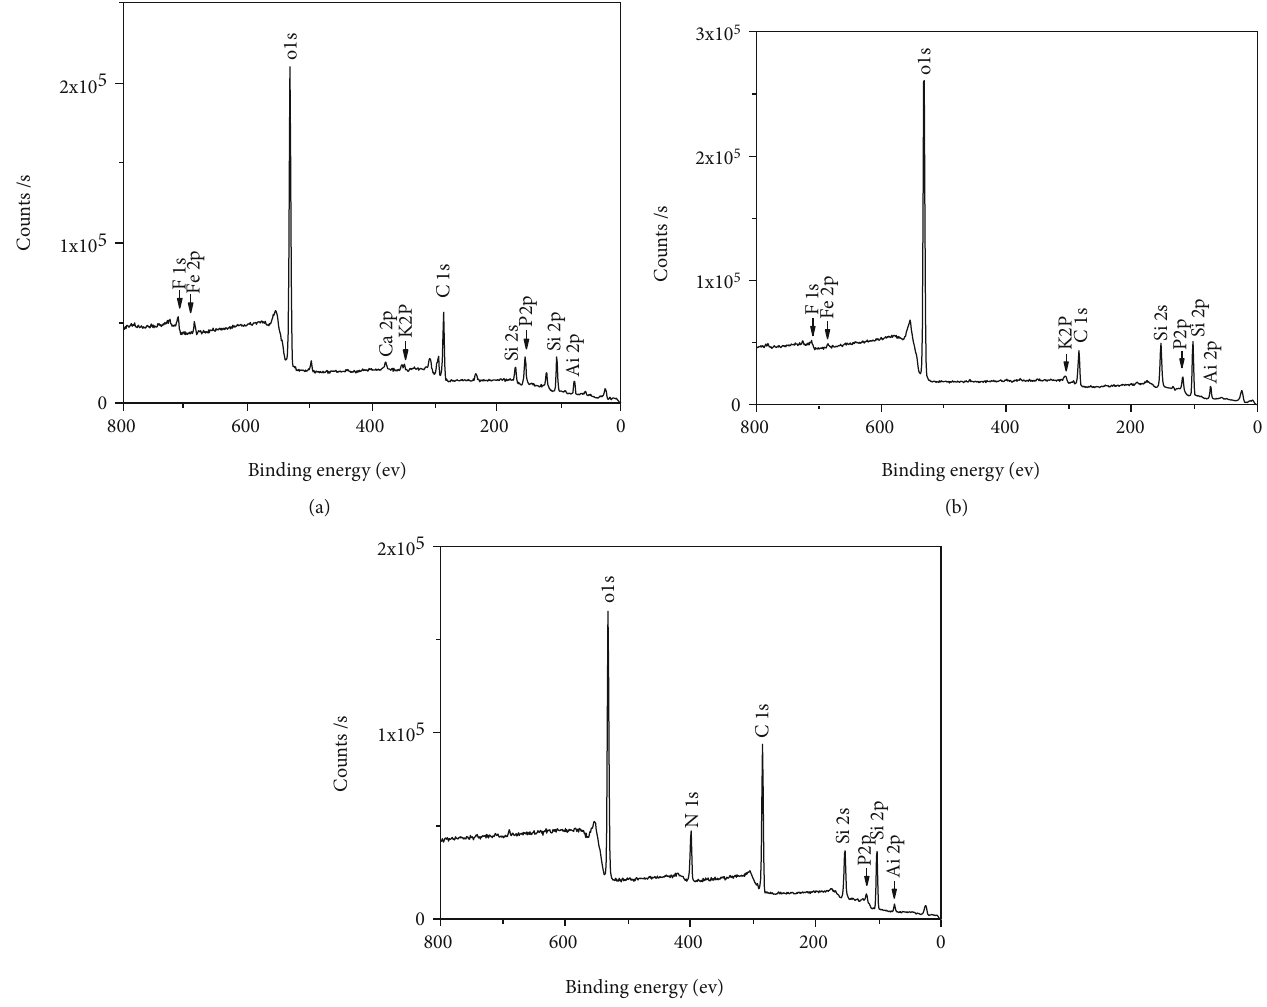
Figure 2: XPS survey scan of (a) pristine LCFA, (b) activated LCFA, and (c)